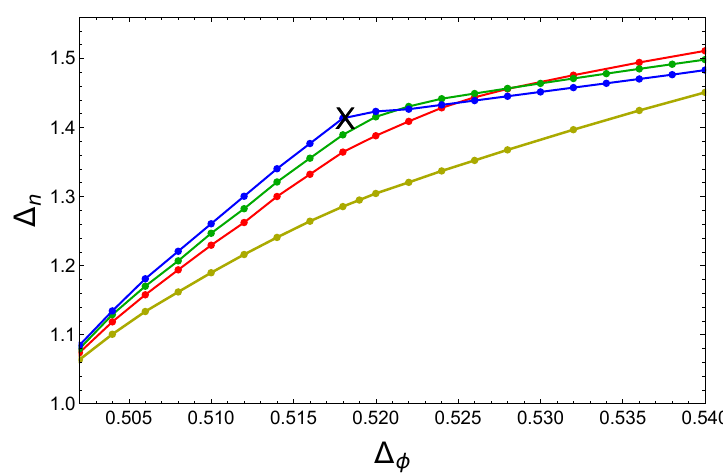
Figure 1 . Numerical bootstrap bound on the scaling dimensions of the first n-channel scalar operators in CFTs with S N Z 2 symmetry (small ∆ φ region). Yellow, red, green and blue curves ⊗ are for N = 4 , 6 , 10 , 100 respectively. The black cross denotes the scaling dimension of Ising model operators (∆ Ising , ∆ Ising ). The bounds are obtained at Λ = σ ǫ